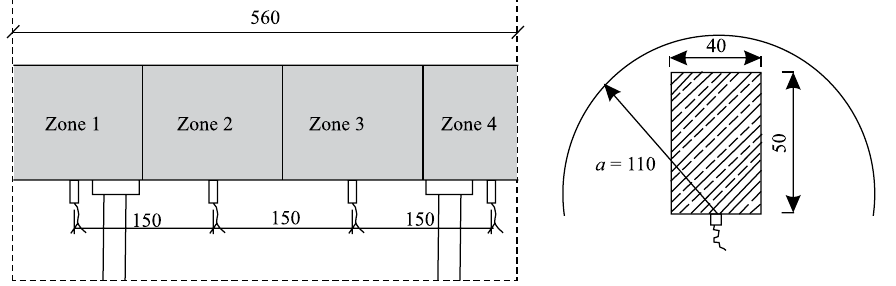
Fig. 10. Arrangement of the AE sensors on the surface of the rib and max range of the measuring zone (measurements in